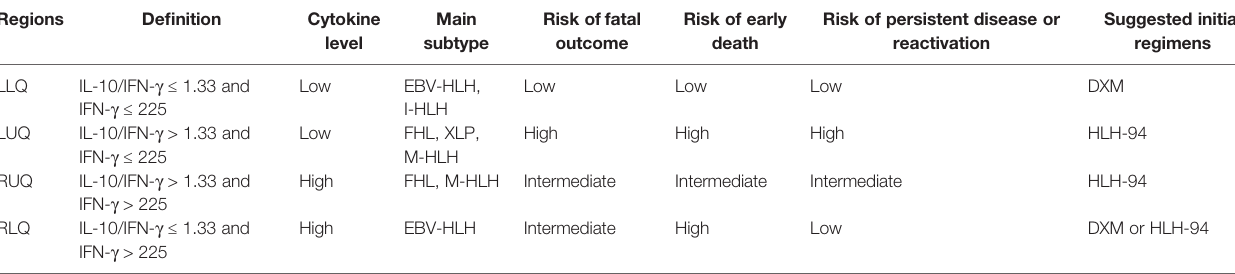
TABLE 4 | Summary of clinical features of HLH subtypes based on four-quadrant